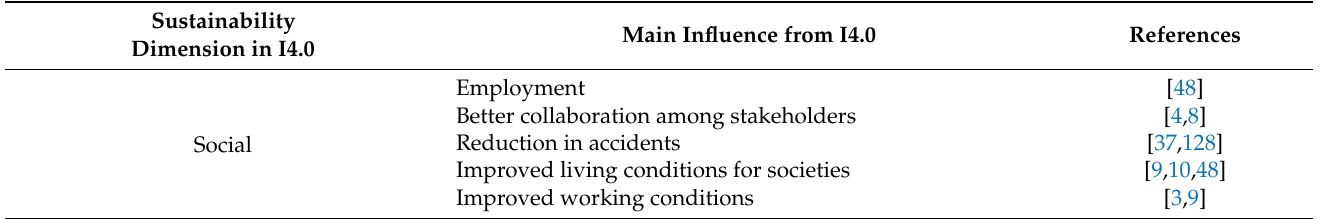
Table 3. Influence of Industry 4.0 technologies on social sustainability. Sustainability Dimension in